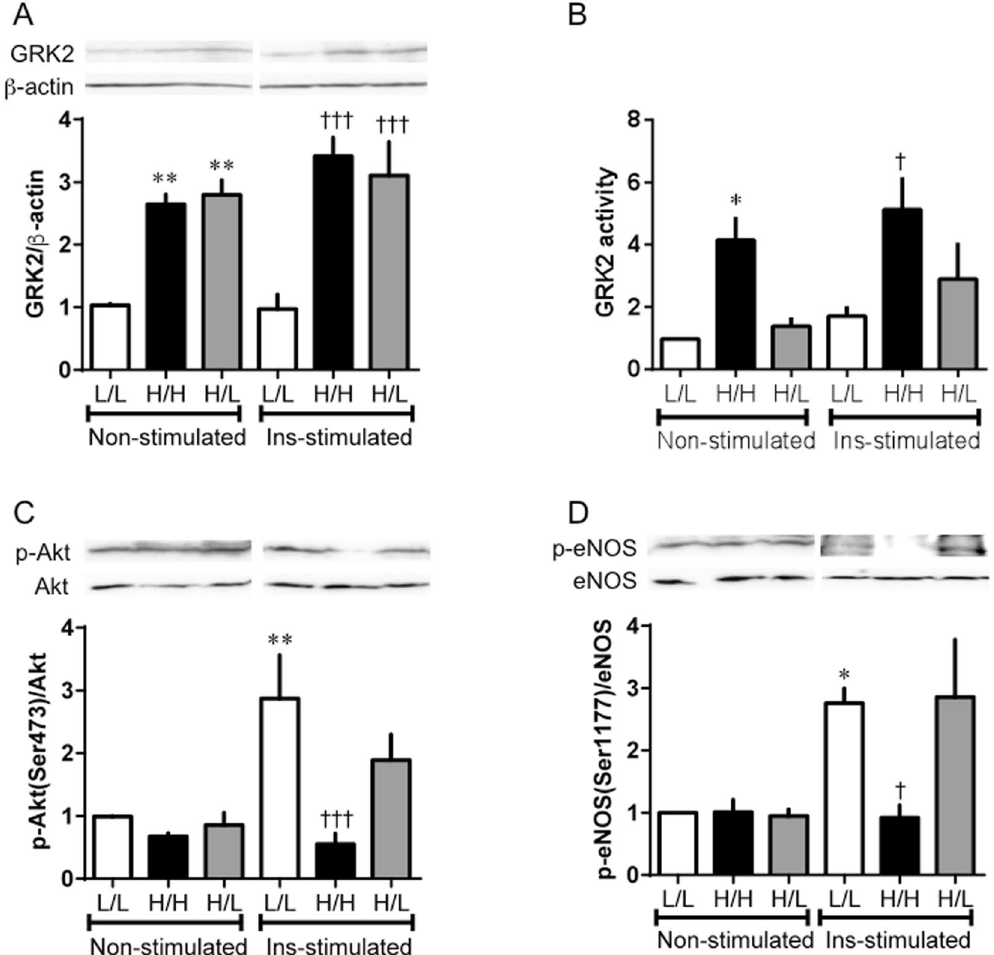
Figure 8. Acute normalization of glucose concentration improved impaired insulin signaling in HUVECs induced GRK2 underHG/HI conditions. HUVECs were incubated for 72 h in LG (5 × 10 − 3 mol/L)- or HG (22 × 10 − 3 mol/L)/HI (10 − 7 mol/L) medium, and then the medium was replaced for 6 h. Finally, insulin (10 − 6 mol/L) was added for 20 min. Abbreviations are defined in Fig. 6. GRK2 ( A ), phospho-Akt ( C ) and eNOS ( D ) were tested by western blotting assay. ( B ) Levels of GRK2 activity in HUVECs. Phosphorylated proteins are normalized to total proteins. Basically, Insulin-stimulated and non-stimulated lanes were run on the same gel but were noncontiguous, and partly, were run on a separated gel but under the same conditions. Values are mean ± SE; n = 6. * p < 0.05, ** p < 0.01 vs. L/L (non-stimulated); † p < 0.05, ††† p < 0.001 vs. L/L (insulin- stimulated) by one-way analysis of